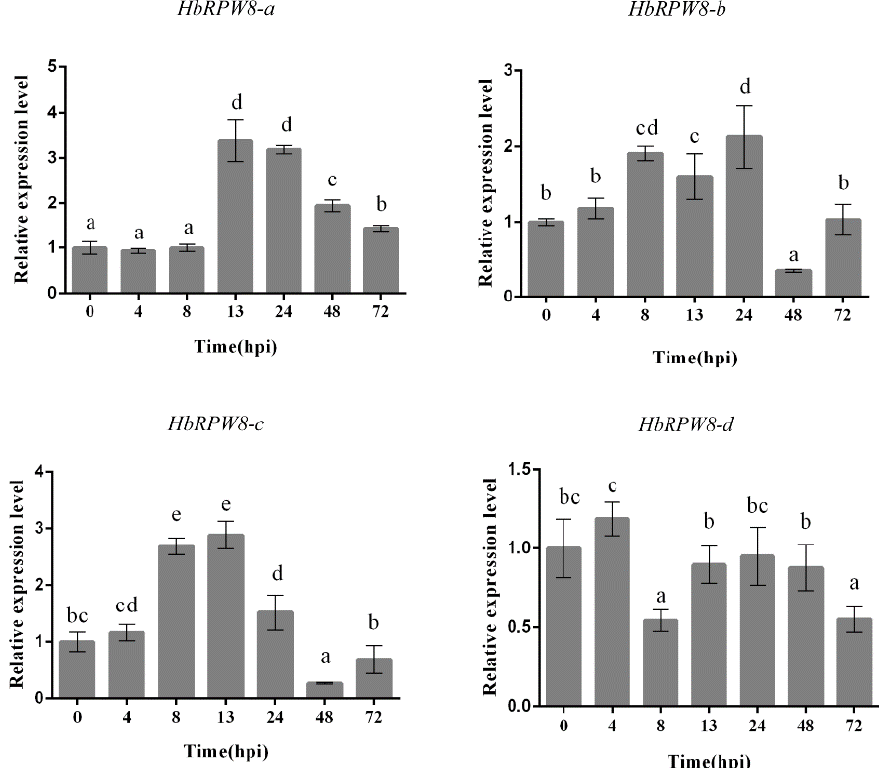
Figure 2. Transcriptional expression of HbRPW8s in response to E. quercicola. The relative expression of each gene was calibrated against 0 h uninoculated samples. The experiment was performed with three biological replicates, and six plants were used in each independent trial. The data were analyzed by one-way ANOVA and Duncan’s multiple comparison tests. Data were showed as means ± standard error. Bars with different lower-case letters show significant differences at the level of p < 0.05.